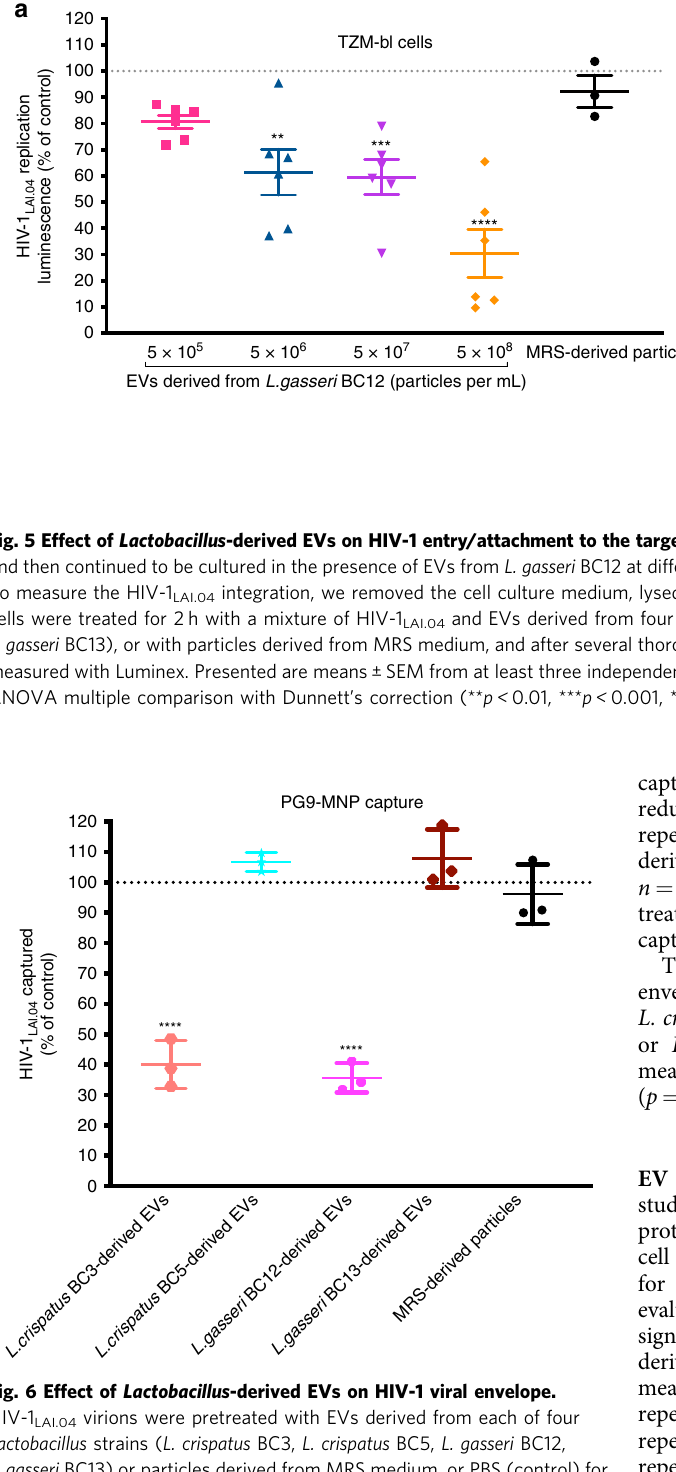
3, repeated-measures ANOVA) or upon pretreatment with